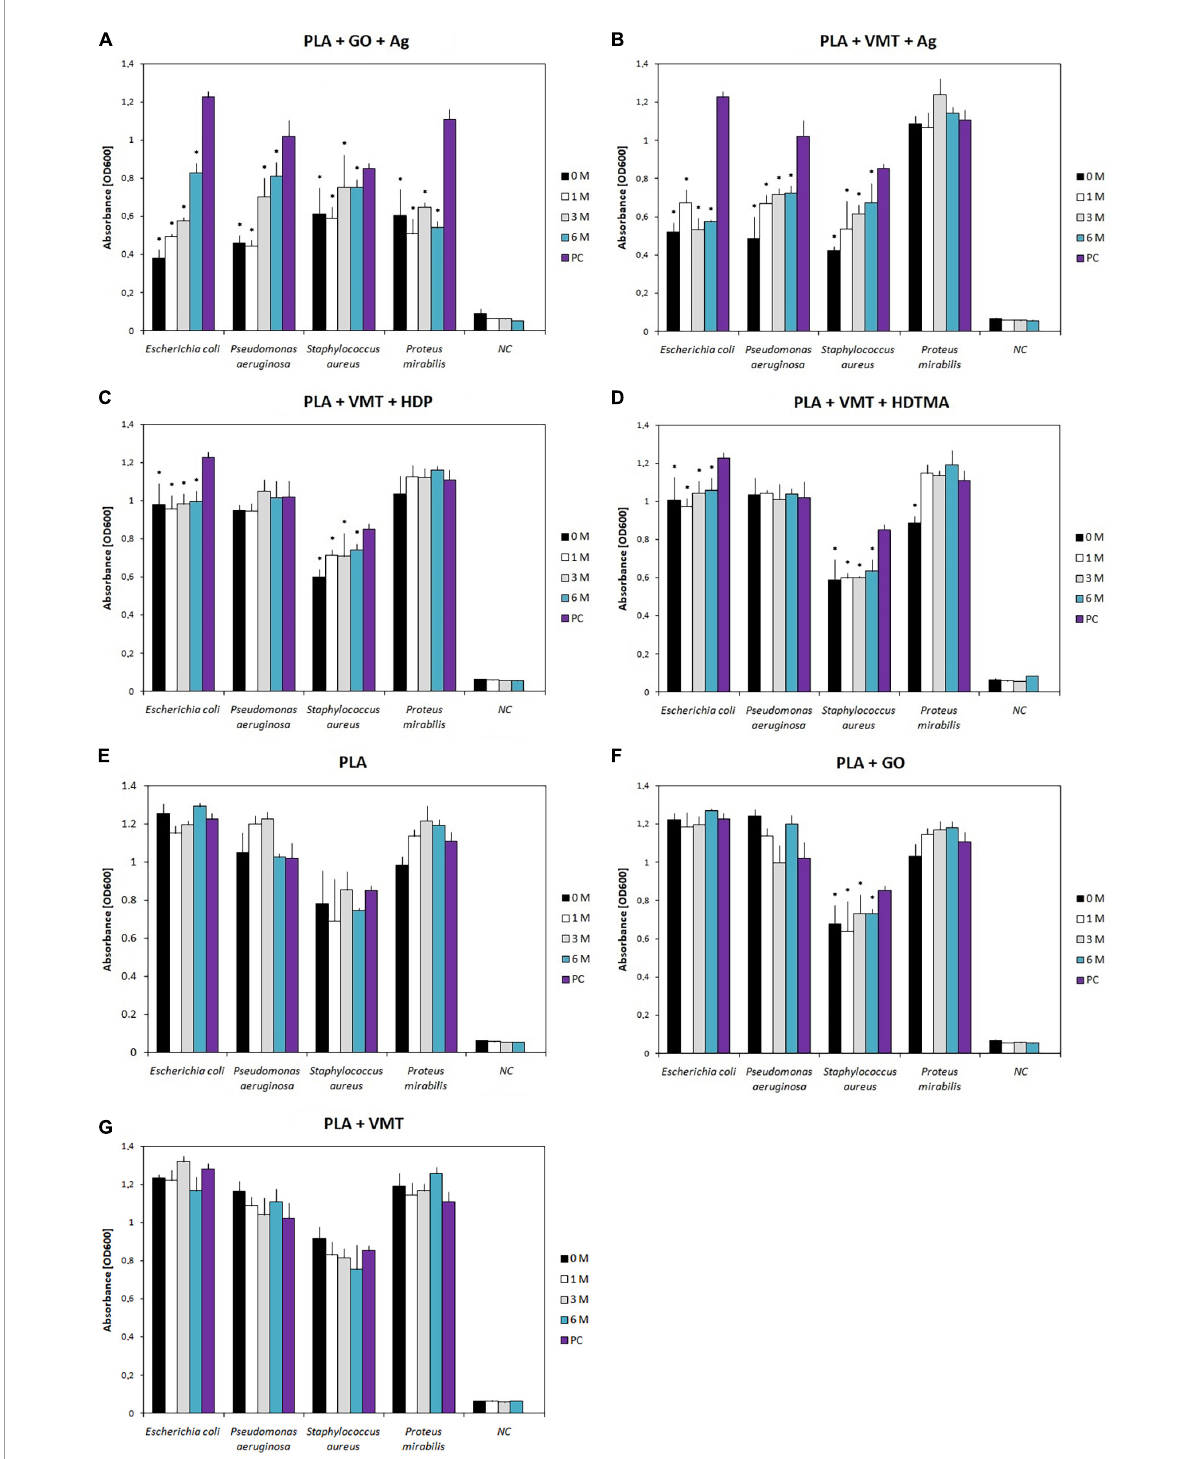
FIGURE1 Influence of polylactide composite PLA + GO + Ag (A) , PLA + VMT + Ag (B) , PLA + VMT + HDP (C) , PLA + VMT + HDTMA (D) , PLA (E) , PLA + GO (F) , and PLA + VMT (G) on the microbial growth after 0, 1, 3, and 6 months of degradation of composites in saline solution. Absorbance measured after 24 h incubation at 600 nm. NC, negative control, composite sample in nutrient medium without microbial strain, PC, positive control, microbial strain in nutrient medium without composite, M, month (time of degradation). ∗ Indicates a significant statistical difference ( p < 0.05) between the microbial strain affected by the sample and the positive